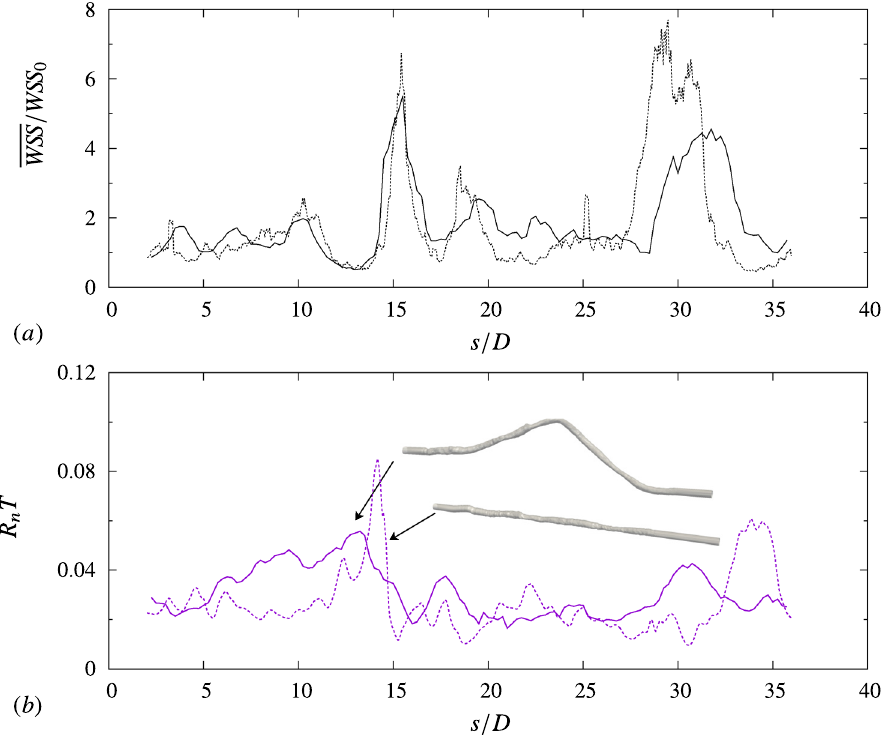
Figure 4. Comparison between simulation results using realistic centerline data and ideal straight centerline: ( a ) WSS normalized by the ideal reference value WSS 0 ≈ 4 Pa ; ( b ) rate of adhesion for neutrophils. Solid lines, realistic centerline; dashed lines, straight